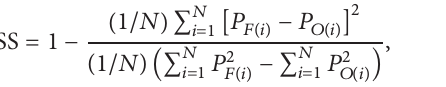
threshold, a perfect forecast would have a bias of 1, while values of bias less than and greater than one represent rainfall underprediction and overprediction,